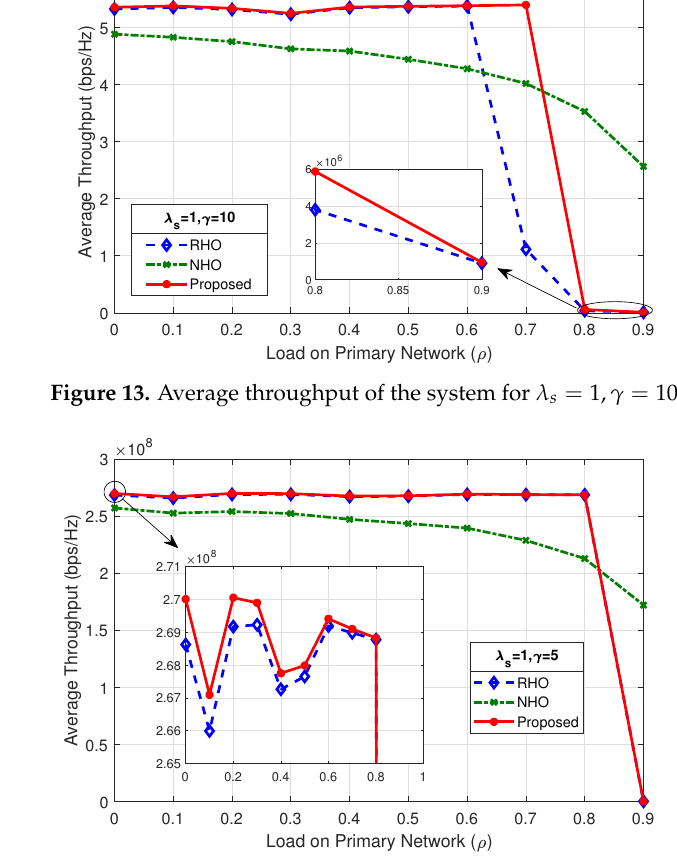
Figure 14. Average throughput of the system for λ s = 1, γ = 5.